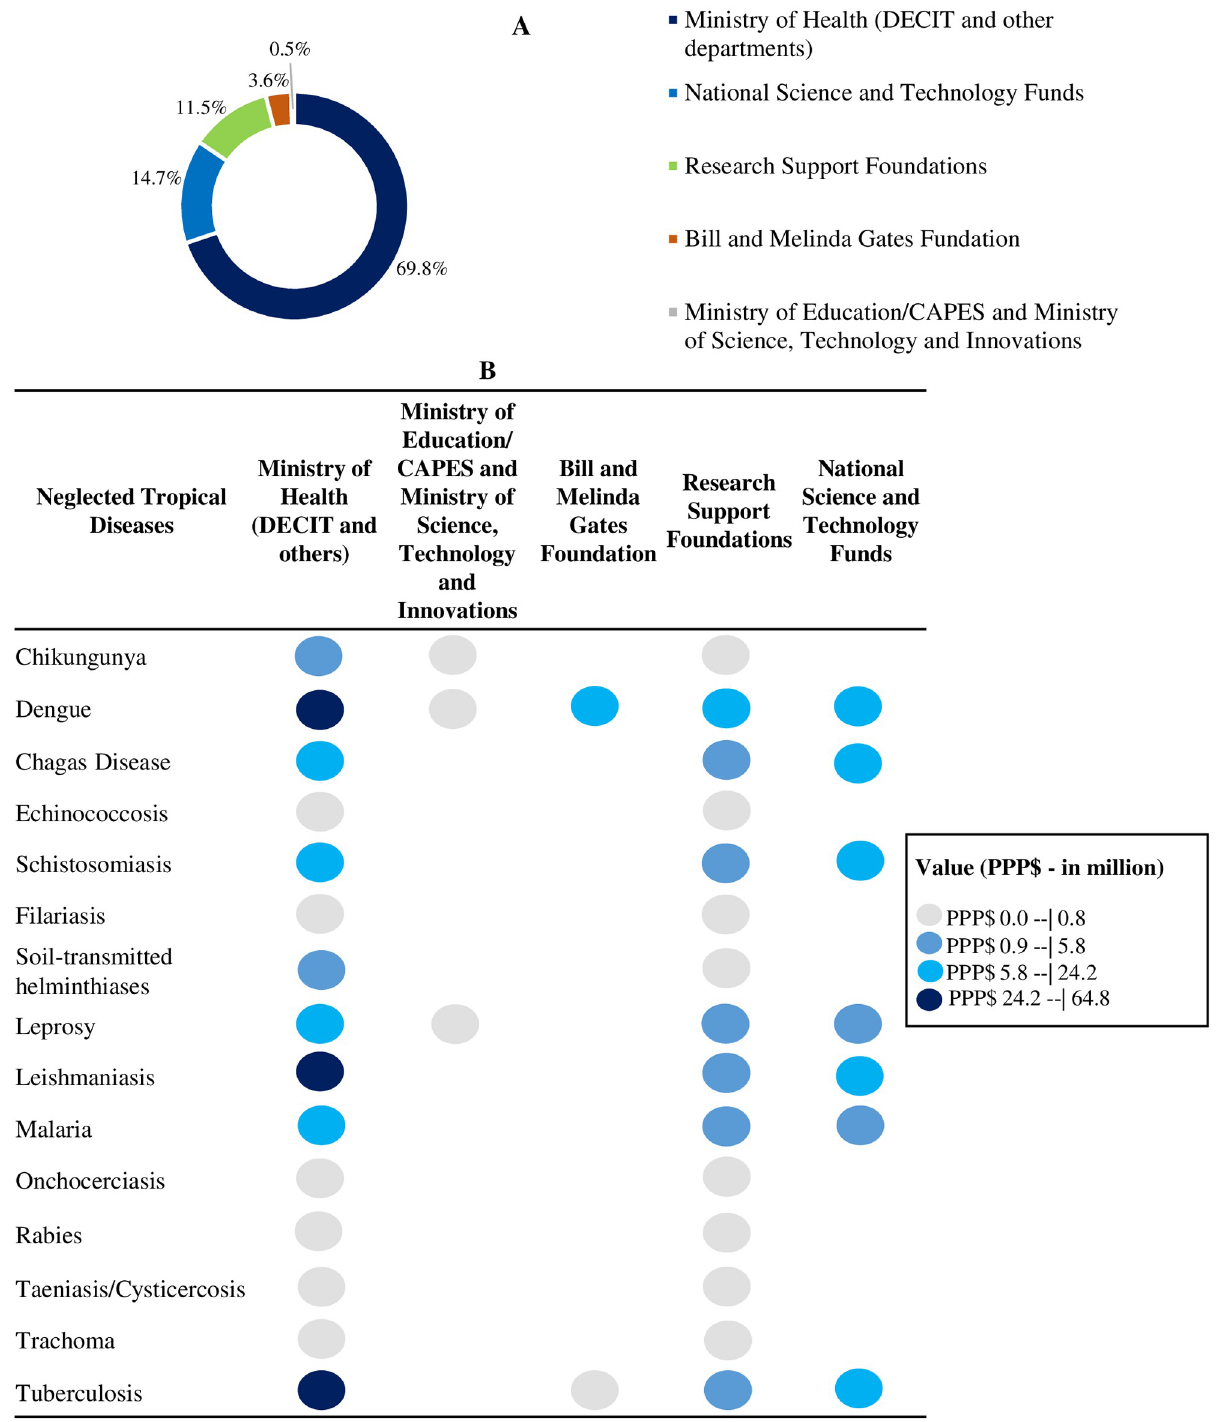
Fig 4. Distribution of research funding on neglected tropical diseases by the Ministry of Health and partners. (A) Percentage of funding by the Ministry of Health and its partners. (B) Amount funded (PPP$) by the Ministry of Health and its partners by type of disease. Brazil, 2004–2020. CAPES–Coordination for the Improvement of Higher Education Personnel; DECIT–Department of Science and Technology; MEC–Ministry of Education; PPP$—Purchasing Power Parity–reference year 2021 (value in million). Note: 105 surveys encompassed more than one neglected tropical disease and were therefore counted more than once. Thus, the funded research value stratified by type of disease is greater than the funded amount. Source: based on data obtained from the Health Research repository [29], accessed in June 2022.